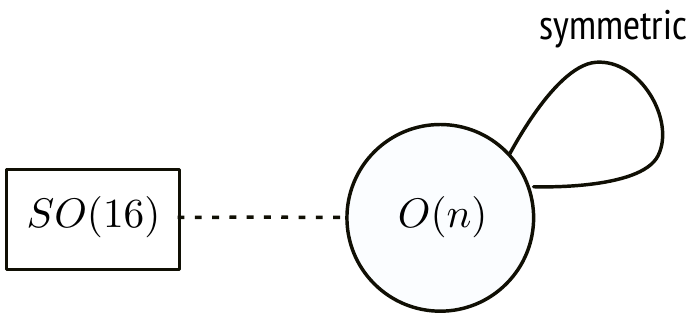
Figure 2 . The quiver diagram of the 2d N = (0 ; 4) gauge theory for E-strings: solid/dotted lines denote hyper/Fermi multiplets,